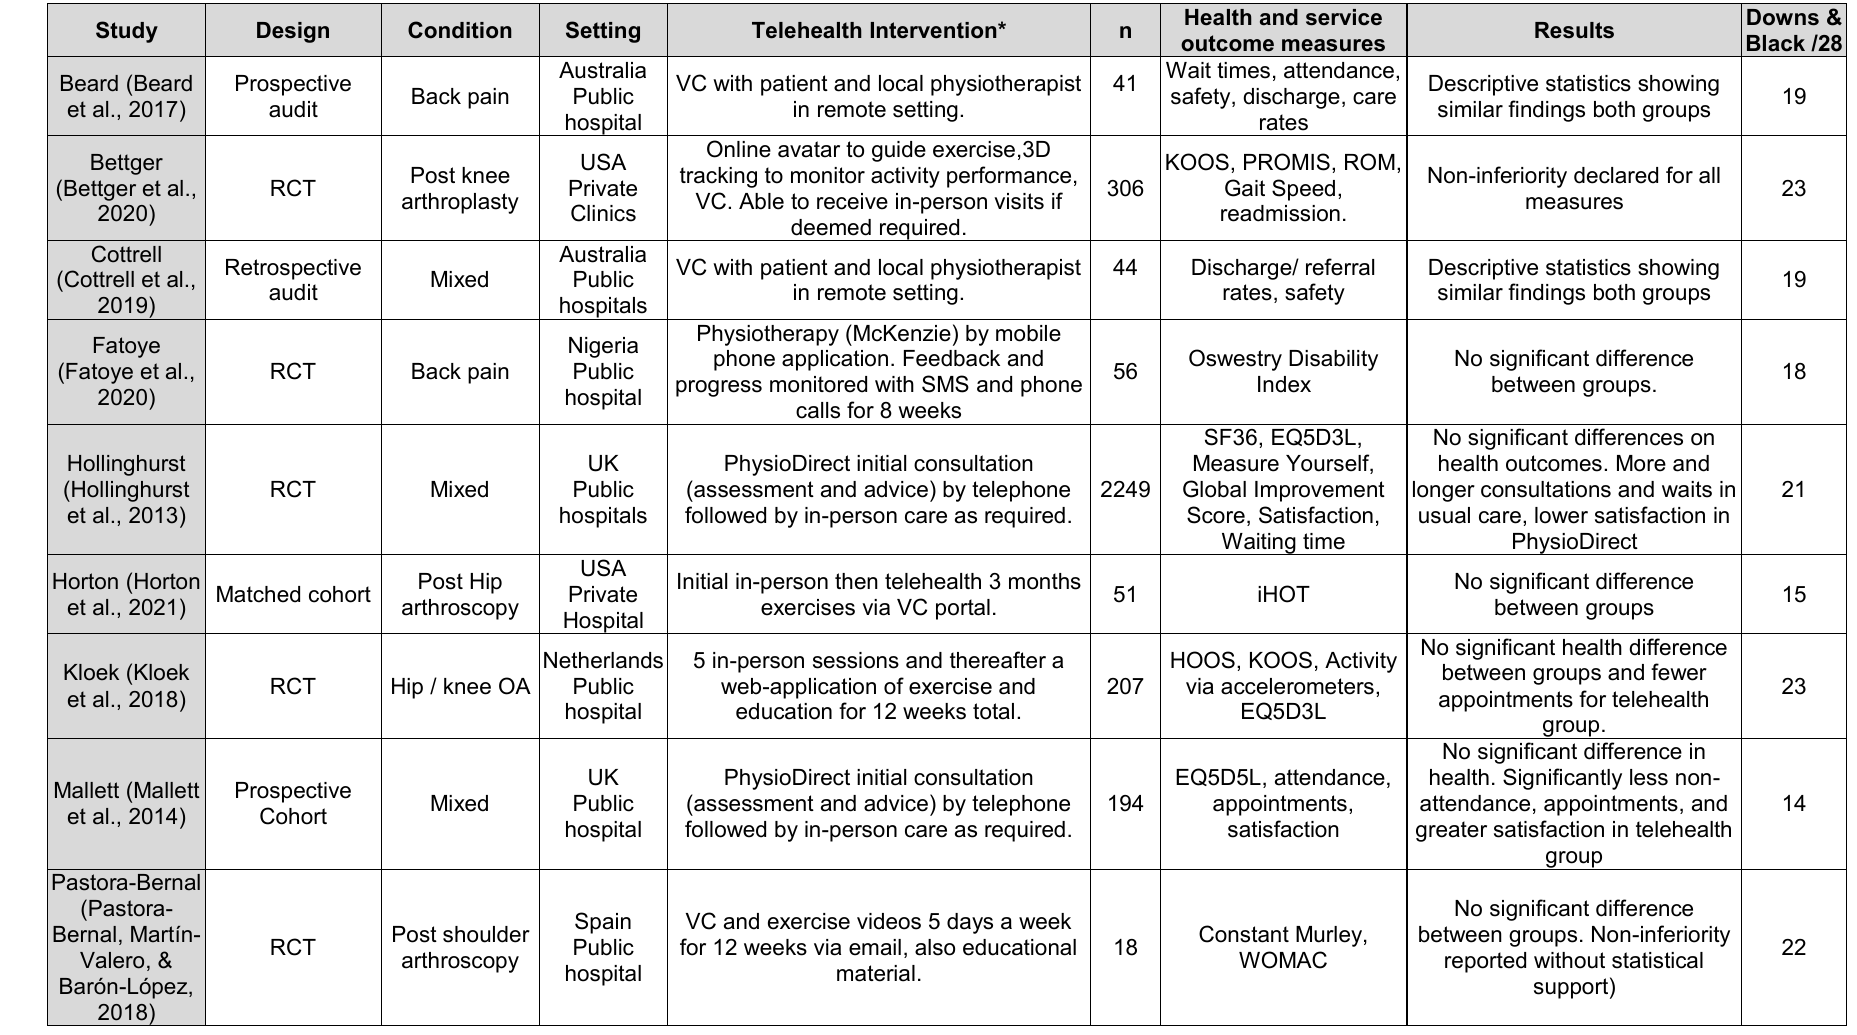
Research Methodology Including Telehealth Interventions, Health-related Results and Quality Appraisal of Included